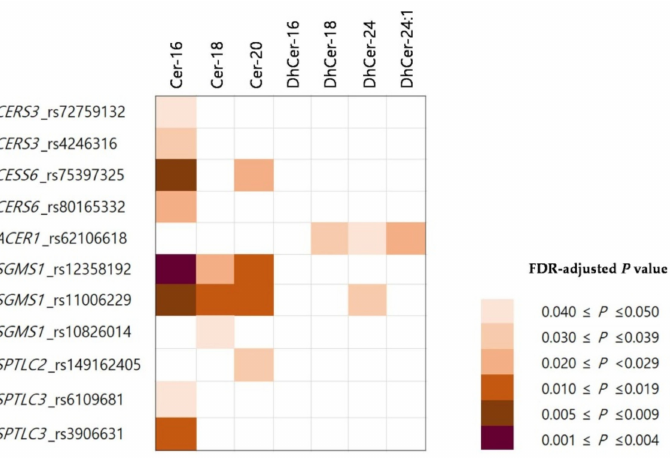
Figure 3. A plot of correlation between SNPs and plasma